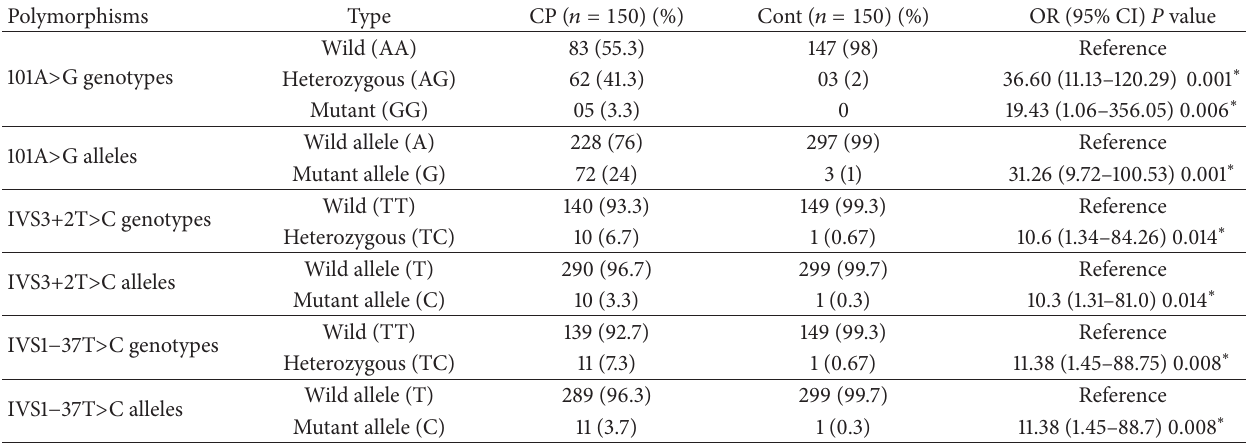
Table 1: Genotype and allele frequency of SPINK1 gene polymorphisms.